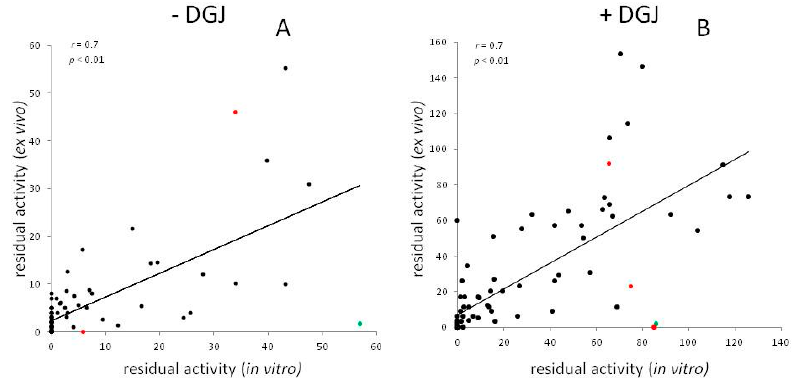
Figure 3. The residual activity of mutants transiently transfected and expressed in vitro and derived from patient cells is shown. In case that multiple reports are available for a given mutant, the average value was plotted. Results in the absence of DGJ ( A ) or in the presence of DGJ ( B ) are reported. Mutations affecting a site of splicing and corresponding to G183, are represented by red symbols, G128E is represented by a green symbol.